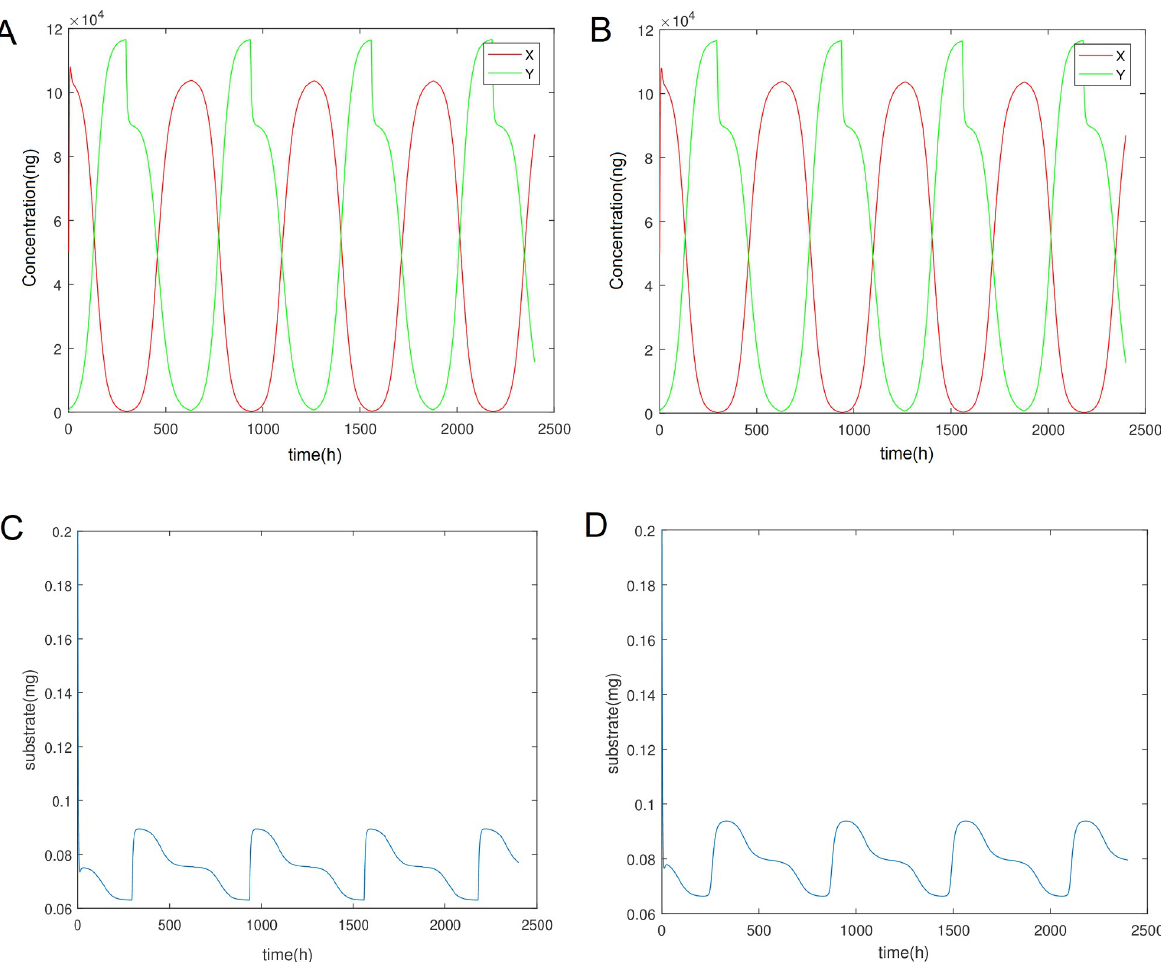
Fig 2. Limit cycle of both the competing populations and the substrate for Eqs (1)–(3). (A) Oscillations of the two biomasses for populations X,Y (Discrete). (B) Oscillations of the two biomasses for populations X,Y (Continuous). (C) Oscillation in the concentration of O 2 (Discrete). (D) Oscillation in the concentration of O 2